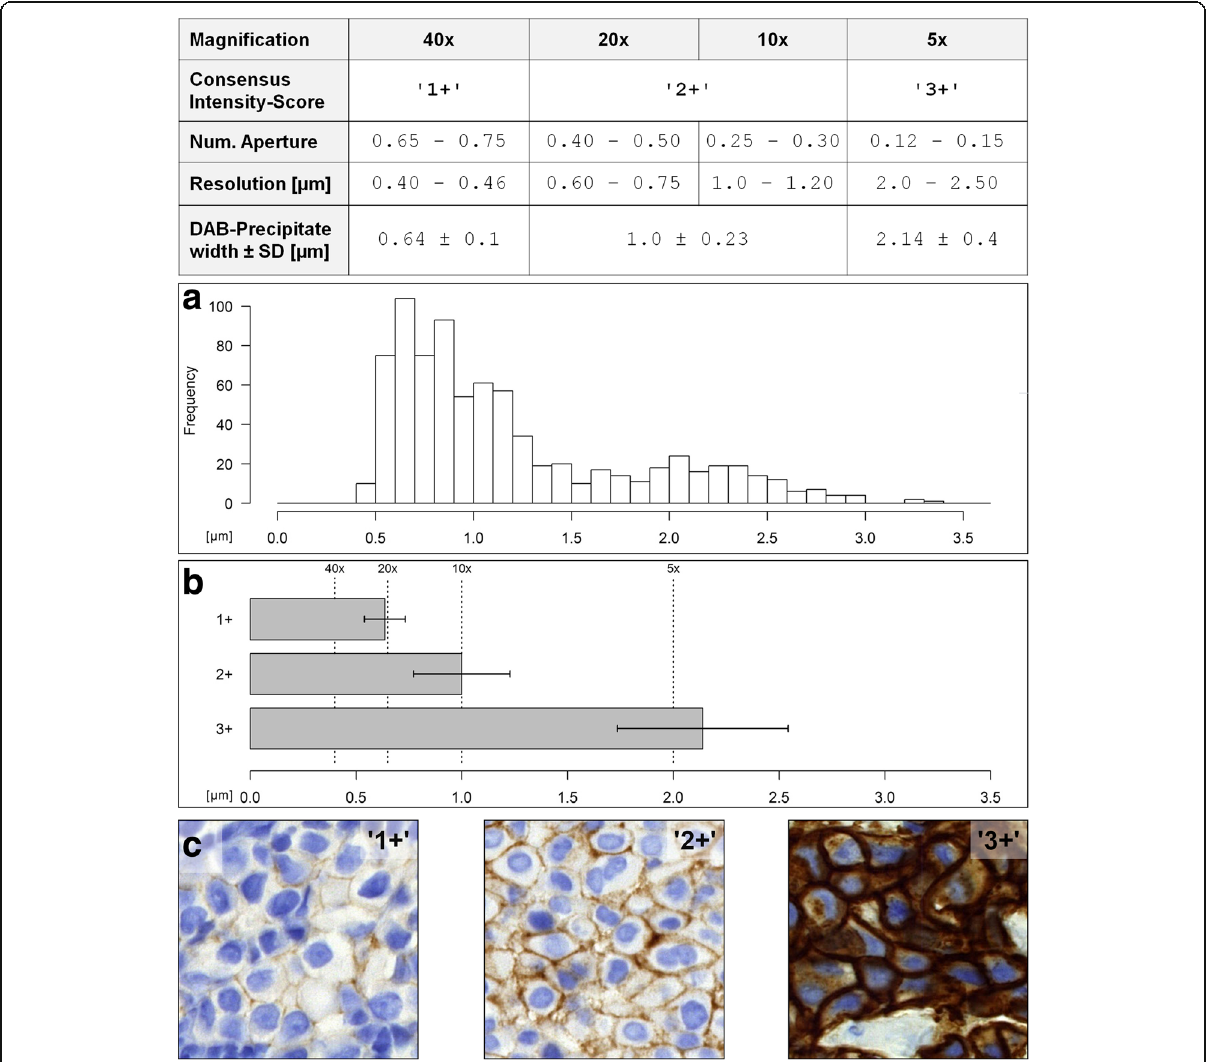
Fig. 1 Her2-IHC scoring categories reflect DAB-precipitate widths. Table: Microscope objectives have a fixed resolution that depends on the numerical aperture (Range: Values of common objectives). DAB-precipitates in HER2-IHC differ in width according to the intensity score. a histogram: Summary of 1200 DAB-precipitate-width measurements in μ m. b bar chart: Mean DAB-width (bars) ±SD (antennae); resolution of standard microscope objectives (dashed lines). c images: Representative HER2-IHC stainings of invasive ductal breast carcinomas according to intensity